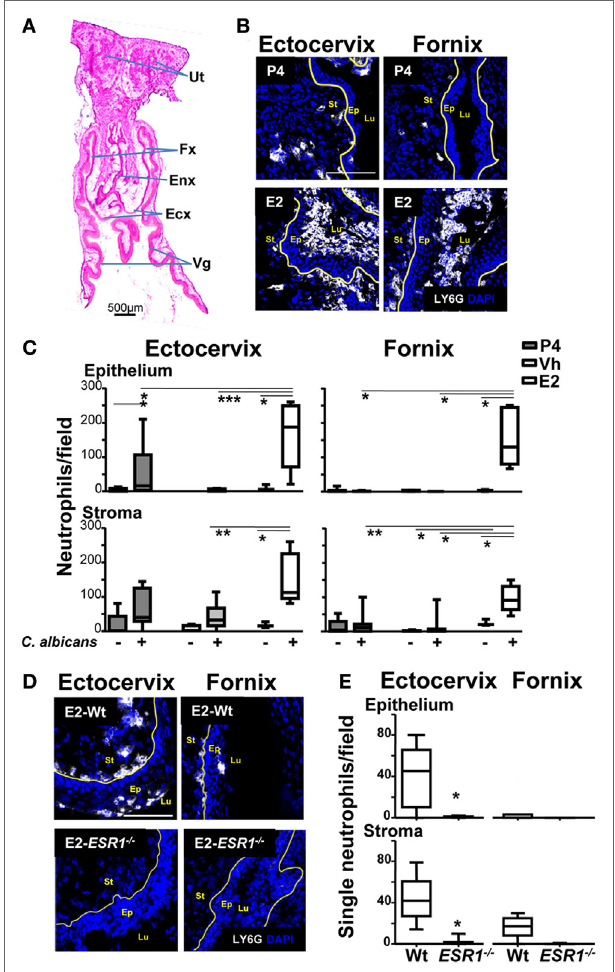
FigUre 2 | Neutrophils in the female reproductive tract (FRT). Hormone- treated ovariectomized mice were mock or Candida albicans inoculated in the vagina for 6 h. (a) Photomicrograph of the FRT. (B) FRT indicating anatomical regions with LY6G-stained neutrophils (white). (c) LY6G + cells/ field in the lower FRT epithelium and stroma. Data were calculated in at least three different sections of each sample ( n = 5). (D) Neutrophils in the vaginal tissue of estradiol treated ESR1 − / − and Wt mice challenged with C. albicans . Representative photographs of ectocervix and fornix stained with LY6G (neutrophils white) and (e) quantification of the neutrophils. Data are expressed as box and whiskers 10–90 percentile ( n = 5). * p < 0.05, ** p < 0.01, and *** p < 0.001 Mann–Whitney. Yellow line indicates the lamina propia. Scale bar, 200 µm. Abbreviations: E2, estradiol; Vh, Vehicle; P4, progesterone; Ut, uterus; Fx, fornix; Enx, endocervix; Ecx, ectocervix; Vg, vagina; Lu, lumen; Ep, epithelium; St,